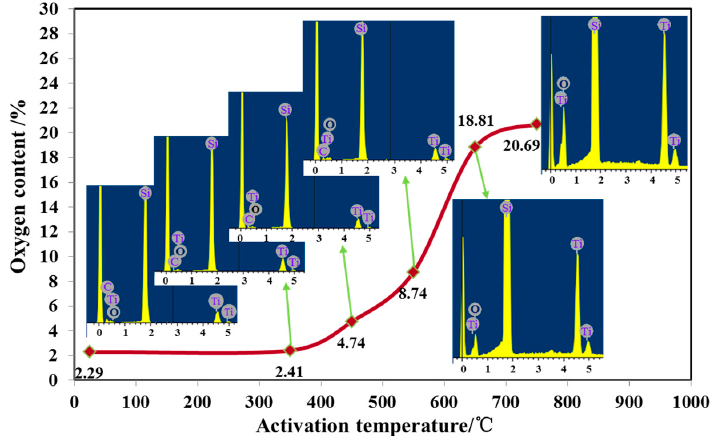
Figure 8. The effect of different activation temperatures on the oxygen content of the films.